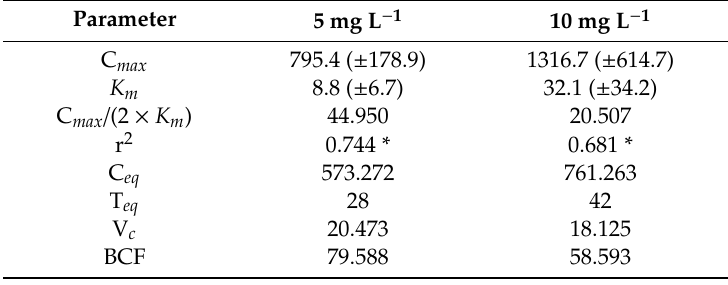
Table 2. Kinetics of Zn accumulation in C. nodosa leaf blades exposed to 5 mg L − 1 and 10 mg L − 1 ZnO NPs.